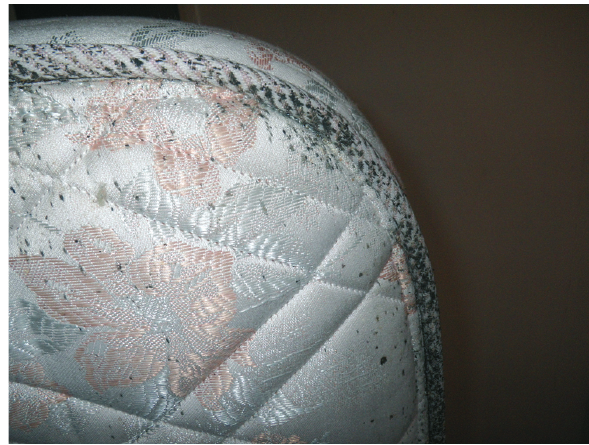
Fig. 2. – Bed bugs excreta on a mattress.